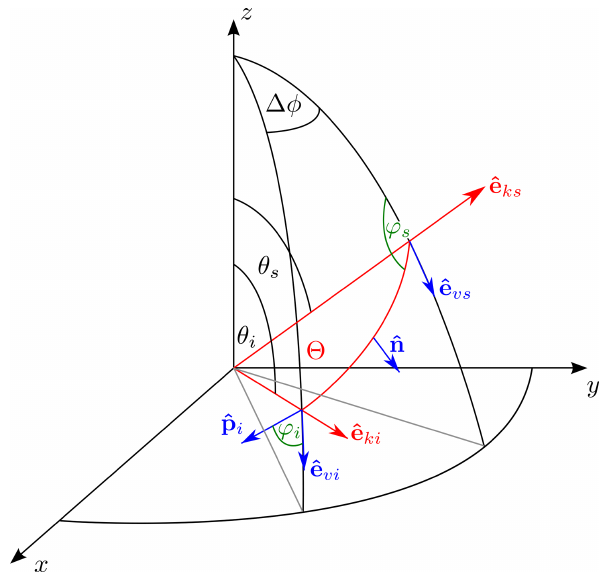
Figure D1. Scattering geometry in the laboratory system